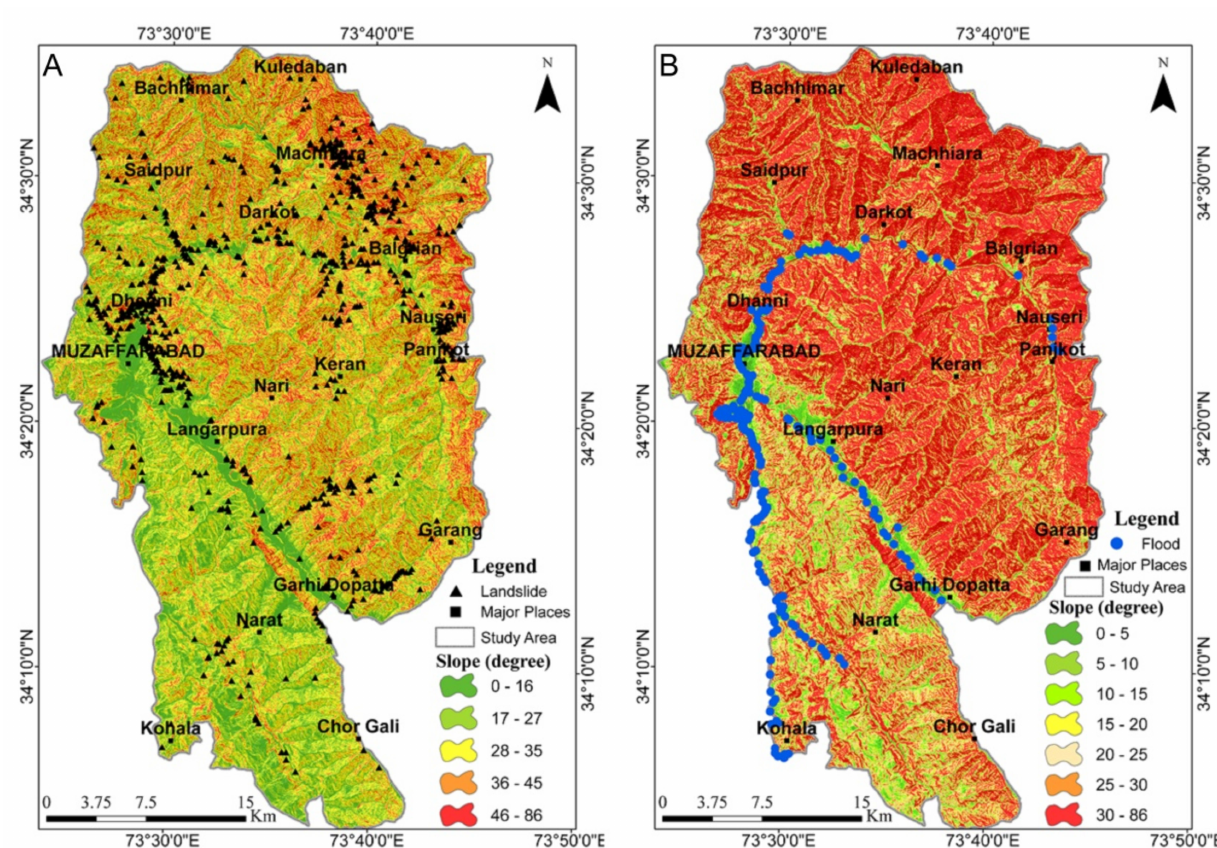
Figure 3. Slope causative factor maps: ( A ) landslide and ( B )